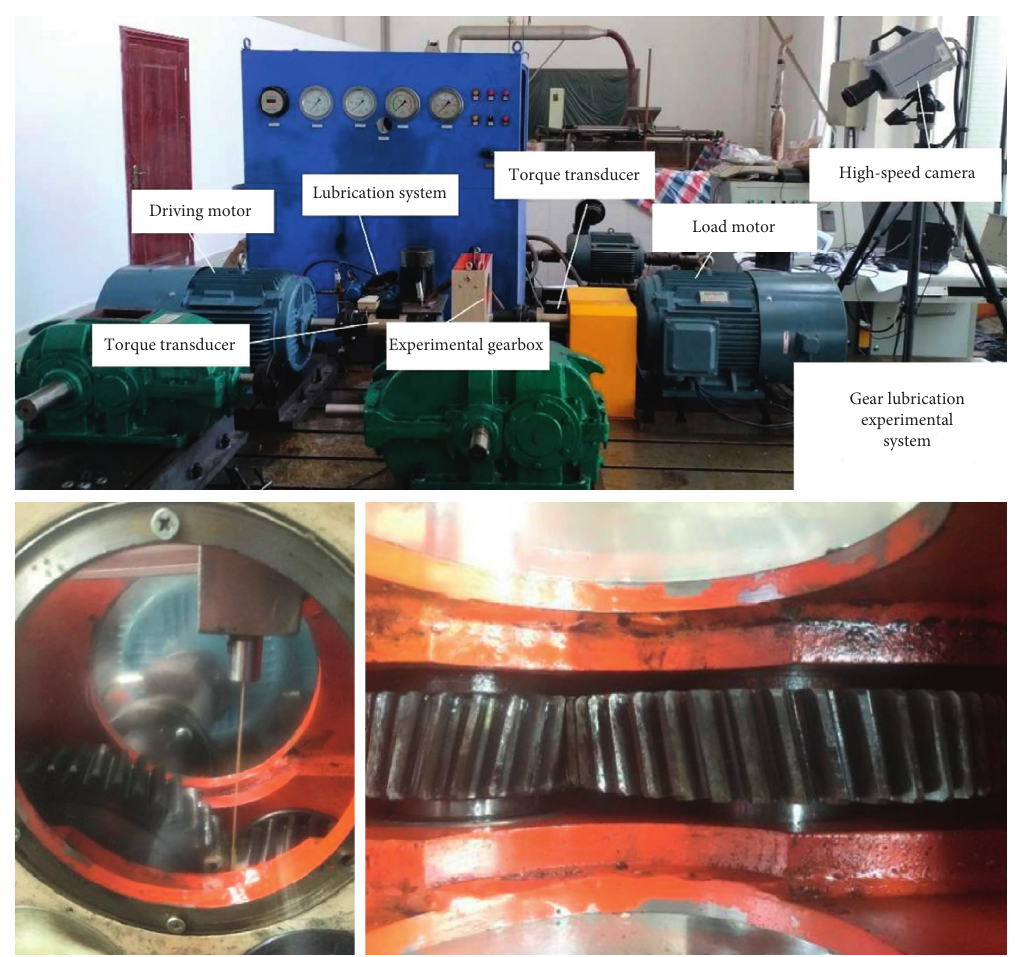
Figure 19: View of the test